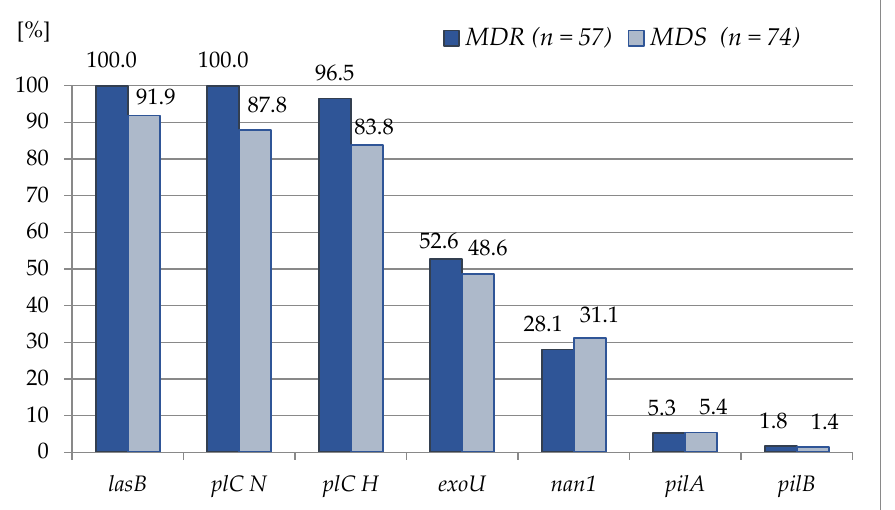
Figure 5. Prevalence of the studied virulence genes amongst the P. aeruginosa strains included in the study with respect to the strains’ antimicrobial susceptibility profiled (multidrug ‐ resistant, MDR, n = 57 vs. multidrug ‐ sensitive, MDS, n = 74).